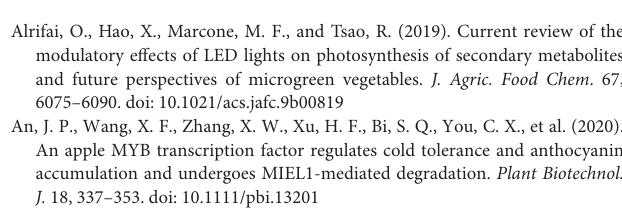
Supplementary Figure 1 | Clusters of differentially expressed transcripts with expression profile changes. (A,B) Changes in gene expression profiles in 24 and 36h treatment groups, respectively. The transcripts were divided into 20 clusters at each time point, representing distinct expression patterns. Colored profiles with significant differential expression at p < 0.05. Supplementary Figure 2 | Correlation analysis of the RNA-seq data and qRT-PCR. The RNA-seq and qRT-PCR results for these genes were highly correlated. The right y-axis shows the expression data of RNA-seq. The left y-axis indicates the corresponding gene relative expression levels detected by qRT-PCR. The x-axis shows different treatments at 24 or 36h. D: dark. W: white light. B: blue light. La: blue light + 1mM LaCl 3 . Supplementary Figure 3 | Phylogenetic tree comprising GmMYB90 and GmMYB114 in Glycine max and R2R3-MYB TFs in A. thaliana . Supplementary Figure 4 | KEGG pathway and GO annotation analyses of genes in MM. green module. (A) The X-axis is the gene ratio and the Y-axis is the pathway type. The bigger the bubble, the more different genes it contains. (B) The X coordinates in the diagram are GO entry names, and the Y coordinates are gene percent. Supplementary Figure 5 | Heat map representation of the expression patterns of genes related to calcium (A) and hormone (B) signal transduction. D: dark. W: white light. B: blue light. La: blue light + 1mM LaCl 3 , 24 or 36h. Supplementary Table 1 | List of primer sequences used in this study. Supplementary Table 2 | List of genes from different module. Supplementary Table 3 | Summary statistics of transcriptome